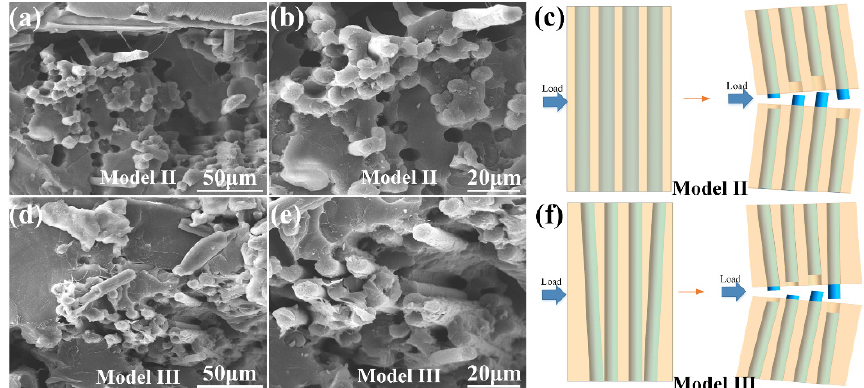
Figure 6. The microstructure of the impact test sample of ( a ) and ( b ) Model II, ( c ) The schematic diagram of impact fracture of Model II. The microstructure of the impact test sample of ( d ) and ( e ) Model III, ( f ) The schematic diagram of impact fracture of Model III.